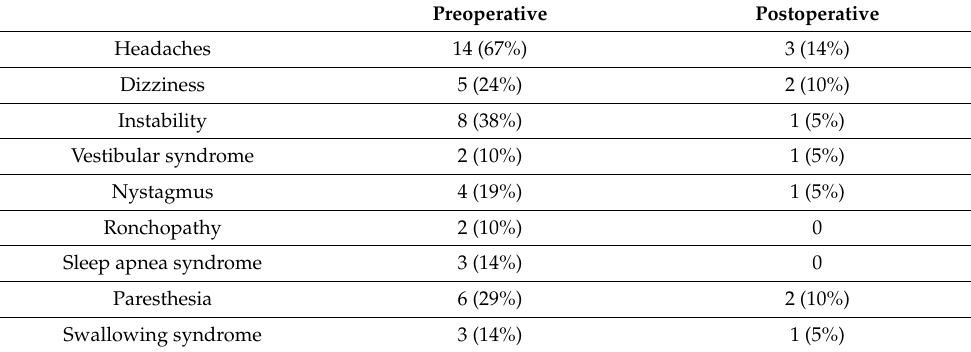
Table 2. Clinical evolution of patient